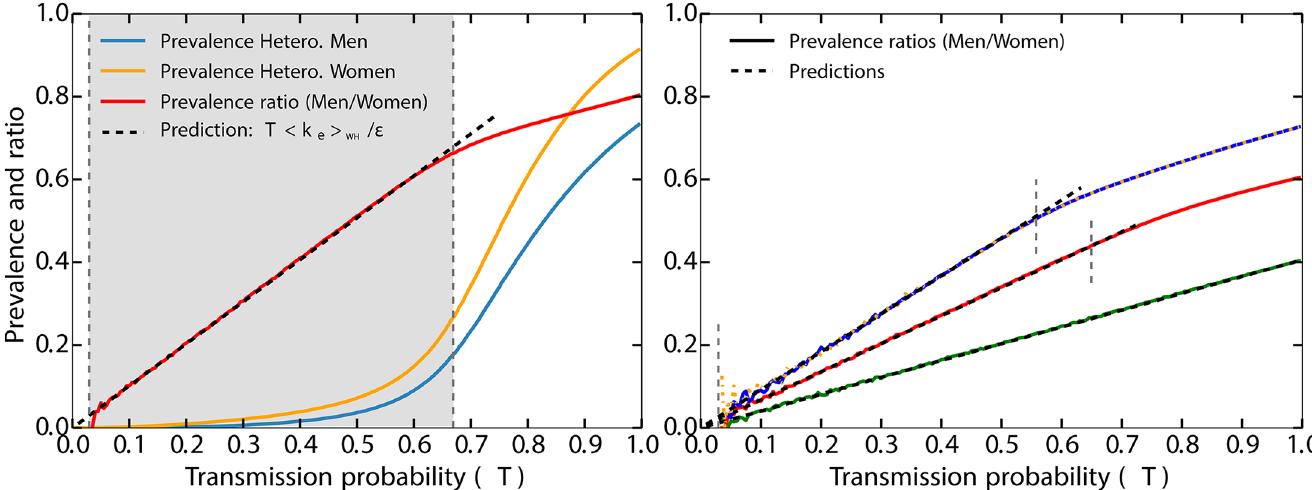
Fig 3. left panel: Validationthat the ratio of incidencein heterosexual men and women equals T h k e i WH / ε , as predictedin the main text using the same results of numerical simulations as for the right panel of Fig 2. The blue and yellow solid lines show the prevalence of ZIKV within the heterosexual men and women sub-populations, and the red solid line shows their ratio. The vertical gray lines and shadedarea are the same as on the right panel of Fig 2. right panel: The black dashed lines show the different predictionsfor the prevalence ratios. The green solid line shows the results of the numerical simulations for the ratio using ε = 5 while keepingthe same values for h k e i WH and h k e i MH as in the left panel(respectively 2.03 and 2.20). The red solid line shows the results for ε = 3, an increasedvalue of h k e i MH (3.51) and an unchanged value of h k e i WH . Notice how the slope increasesby a factor 5/3. The blue solid line shows a similar scenarioas the red one, but one where h k e i WH has also been increased(2.75), thus yieldinga steeper slope. Finally, the orange dotted line (almost completely under the blue one) shows the same scenarioas the blue line, but one in which the averageexcess degreeof bisexualmen has been increased(from 5.40 to 7.72 without any effect, as predicted). The vertical dashed gray lines show the different thresholds corresponding to their respective R 0 equals1 (see Eqs (1) and (2)). Altogether, these results confirm that h k e i WH and T / (cid:15) are the only quantitiesaffecting the risk factor of heterosexual women comparedto men.